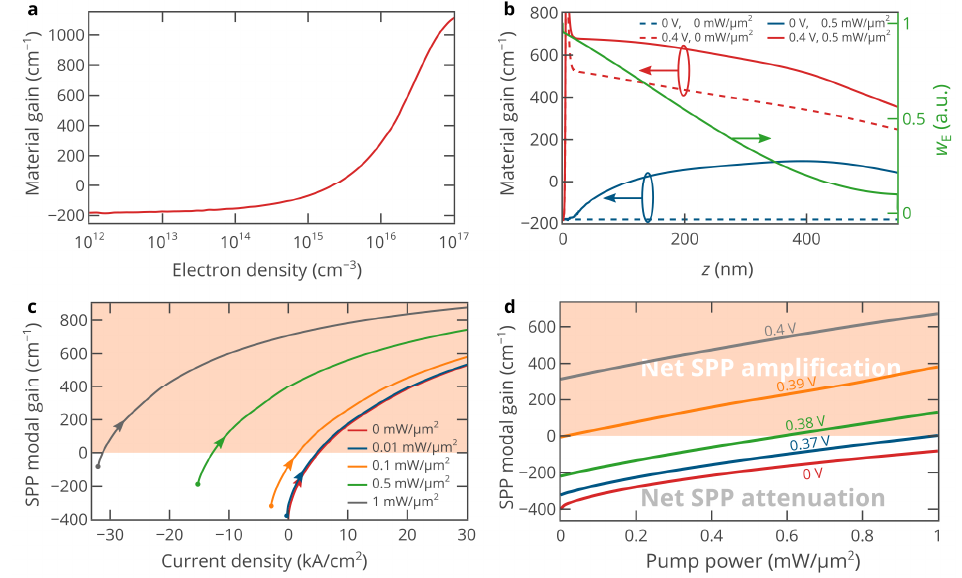
Figure 2. ( a ) Material gain of p -type-doped InAs at a free-space light wavelength of 3.26 µ m as a function of free electron density calculated employing Stern’s model for interband transitions in heavily-doped semiconductors [39,44], which accounts for the band tails in the density of states arising due to a chaotic screened potential of charged dopants. ( b ) Spatial distribution of the material gain across the InAs layer at bias voltages of 0 and 0.4 V in the presence and absence of optical pumping (0.5 mW / µ m 2 ). To estimate the overlap of the gain and mode profiles, the spatial distribution of the electric energy density of the SPP field is also shown. ( c ) SPP modal gain as a function of the current density at di ff erent levels of optical pumping. The dots on the curves correspond to V = 0 V, while the arrows show the direction of the bias voltage increase. ( d ) SPP modal gain as a function of the optical pump power density at five di ff erent bias voltages. In panels ( c ) and ( d ), the region that corresponds to the net SPP amplification is shown in red.